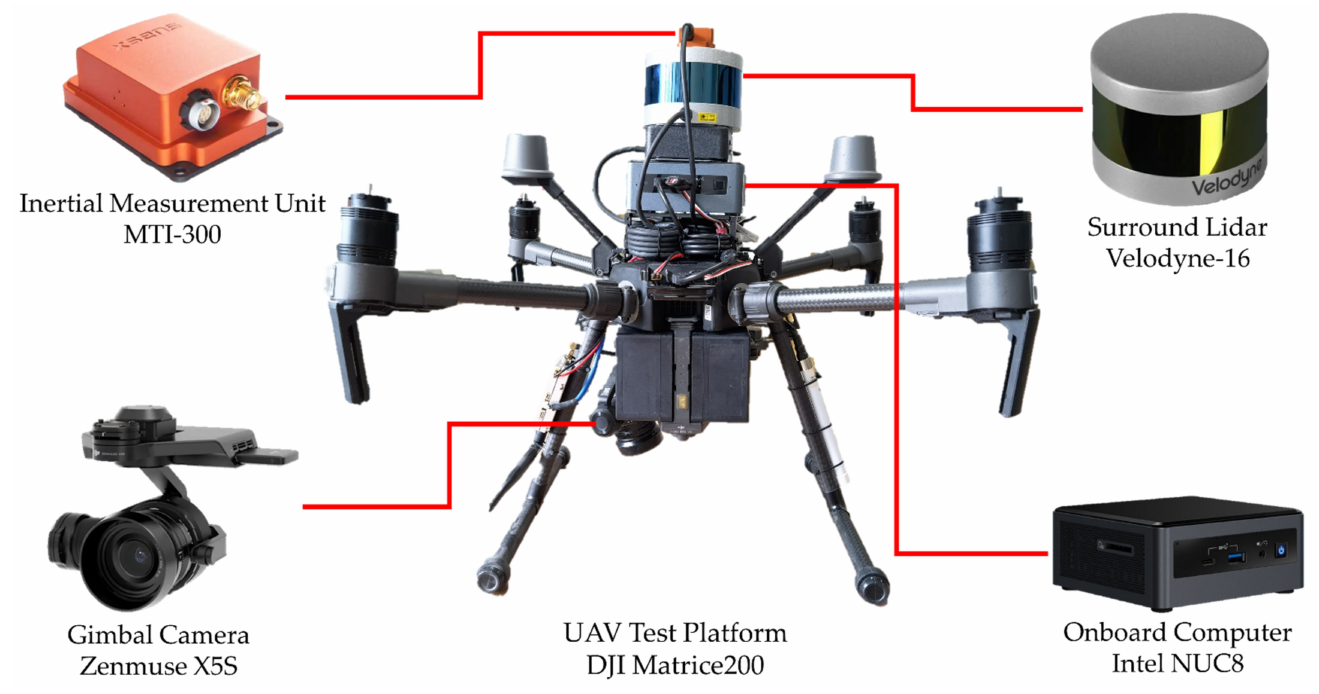
Figure 4. The hardware and the UAV